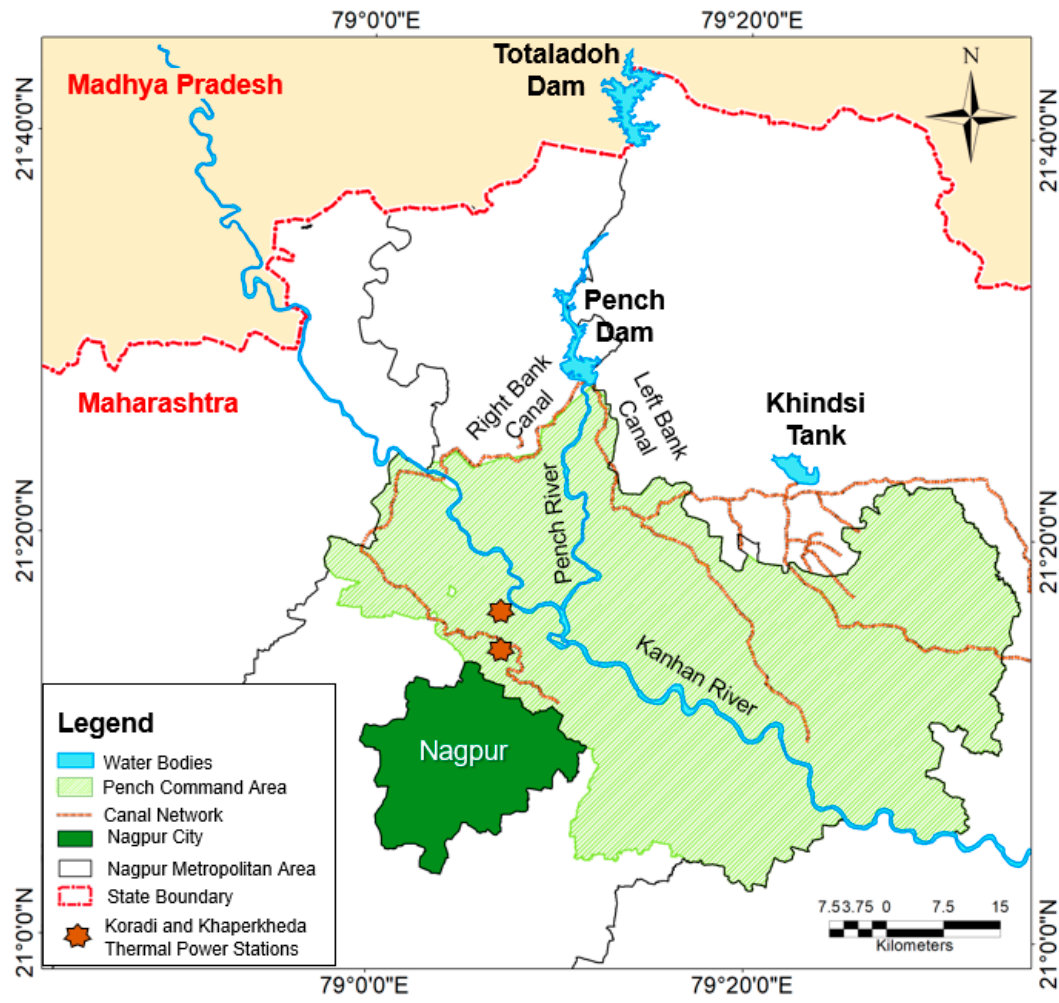
Figure 4. Spatial description of Pench Irrigation Project in Nagpur Metropolitan Area (NMA).